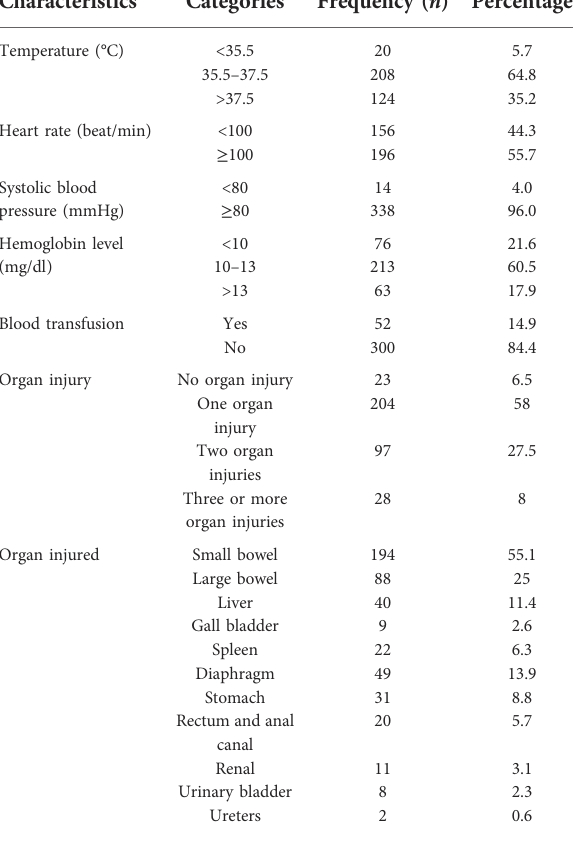
TABLE 2 Clinical characteristics of patients with PAI in the study to assess the treatment outcome and pattern of penetrating abdominal trauma victims who underwent surgical exploratory laparotomy during 2015 – 2019 at HFSUH, eastern Ethiopia.